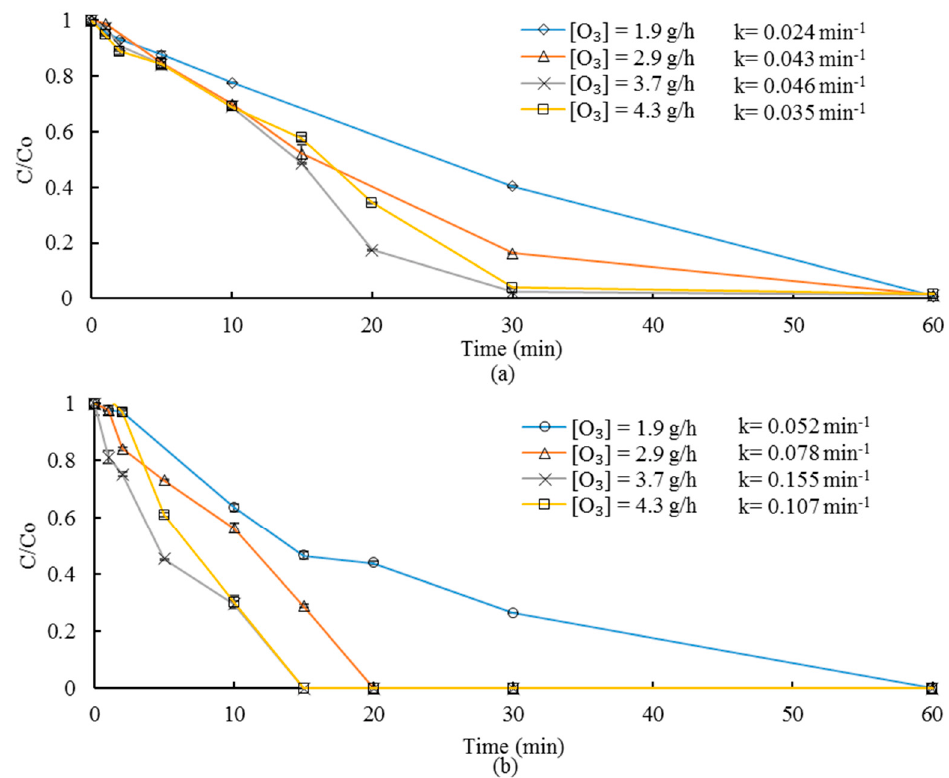
Figure 5. Sulfolane degradation in SWW with UV / O 3 ; ( a ) no dilution, Co = 100 mg / L and ( b ) 5 × dilution. Co = 20 mg / L. The error bars represent the variation of duplicates.